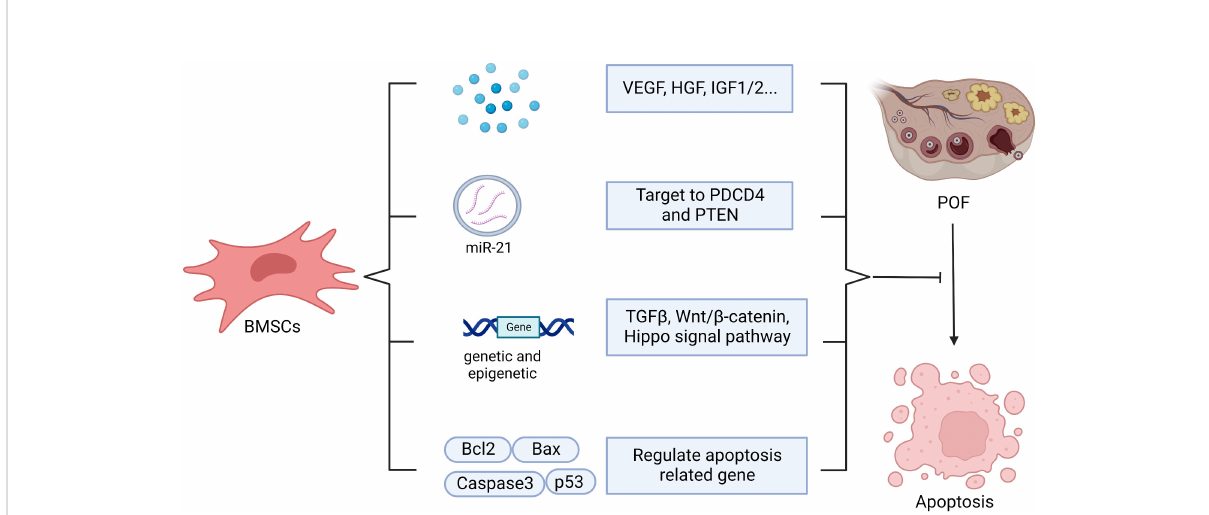
FIGURE 6 The possible mechanisms of BMSCs in anti-apoptosis. BMSCs help to inhibit apoptosis through secreting vesicle containing microRNA-21(miR- 210), which targeting to PDCD4 and PTEN, or secreting vascular endothelial growth factor (VEGF), hepatocyte growth factor (HGF), insulin-like growth factor 1/2 (IGF1/2) or and regulating apoptosis related gene, including Bcl2, Bax, Caspase3, p53, as well as regulating genetic and epigenetic via TGF b , Wnt/ b -catenin, Hippo signal